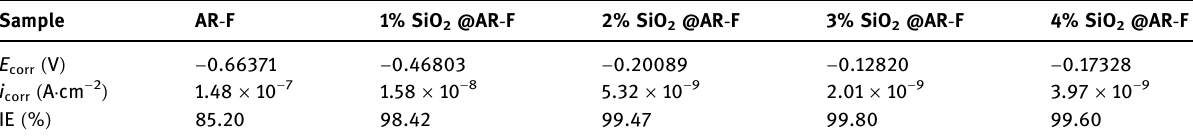
Table 3: Electrochemical parameters of coatings with di ff erent SiO 2 contents immersed in 3.5 wt% NaCl solution